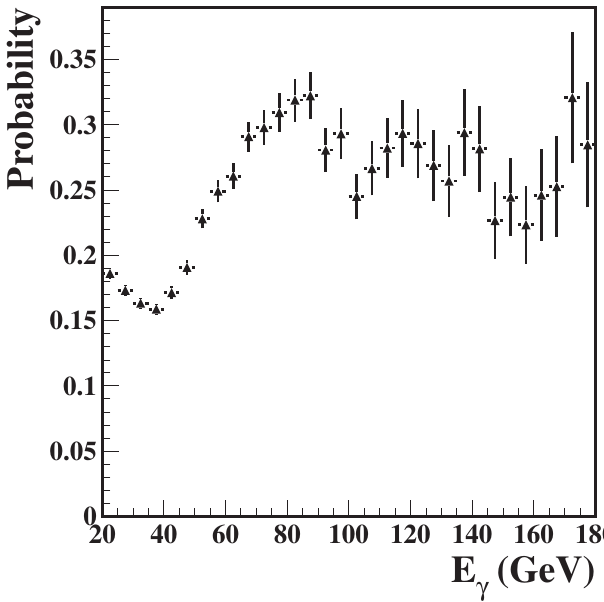
FIG. 19. Absorption probability found from the ratio of the single photon spectrum for the data with and without the quarter wave